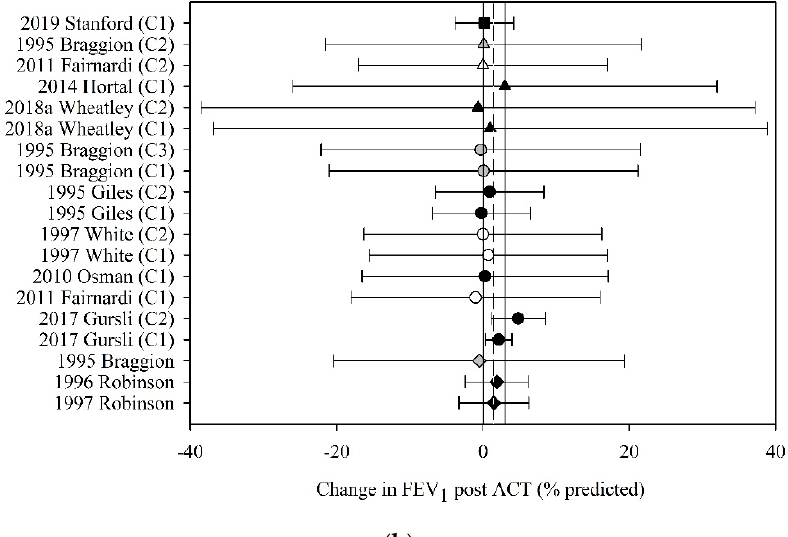
Figure 4. Pooled estimate-FEV1: ( a ) FEV1 (litres); ( b ) FEV1 (% predicted). ACT = airway clearance techniques, C_ = crossover intervention, L = litres ■ = positive pressure device (PPD), % predicted = percent predicted, ▲ = positive expiratory pressure device (PEP), ● = other techniques (OT), ♦ = cough alone (C), closed symbol = stable population, open symbol = acute population, grey symbol = mixed population or nil info, dashed line = pooled estimate, solid vertical line = 95% CI, all individual data presented as mean ± SD.